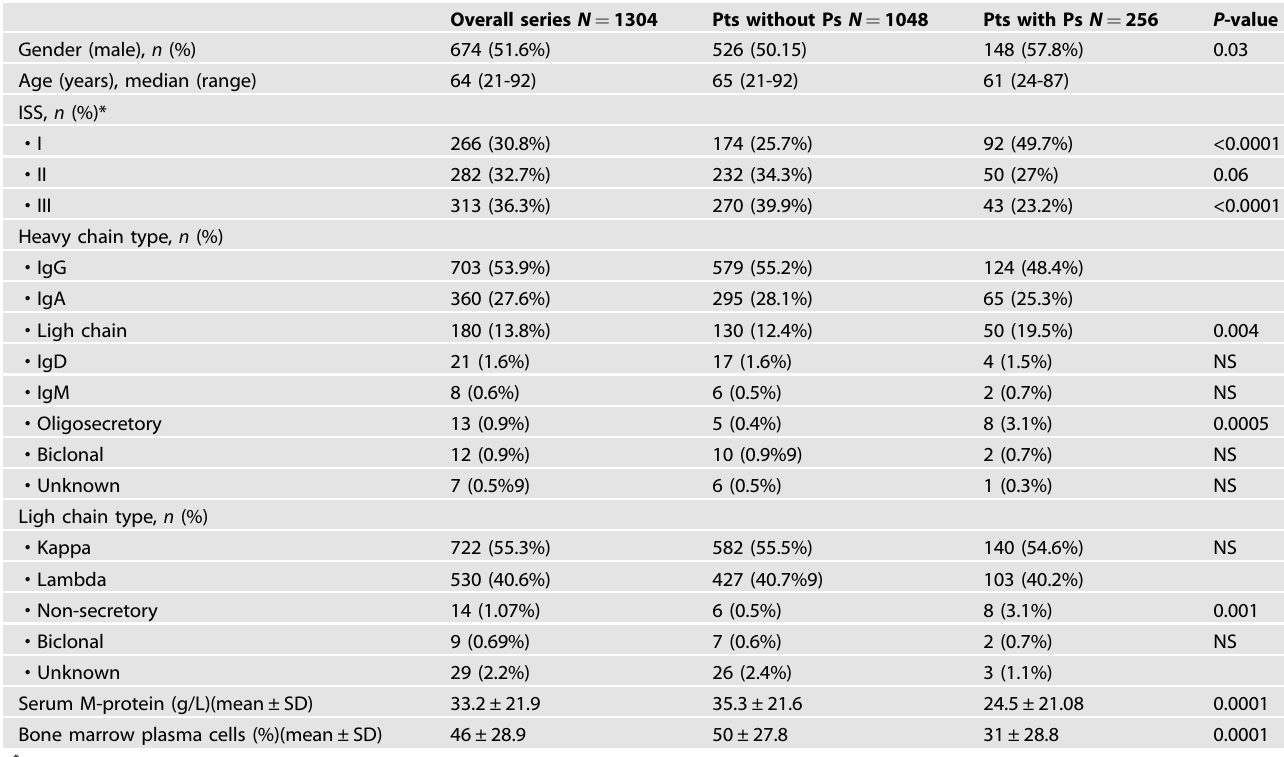
Table 1. Baseline characteristics of the